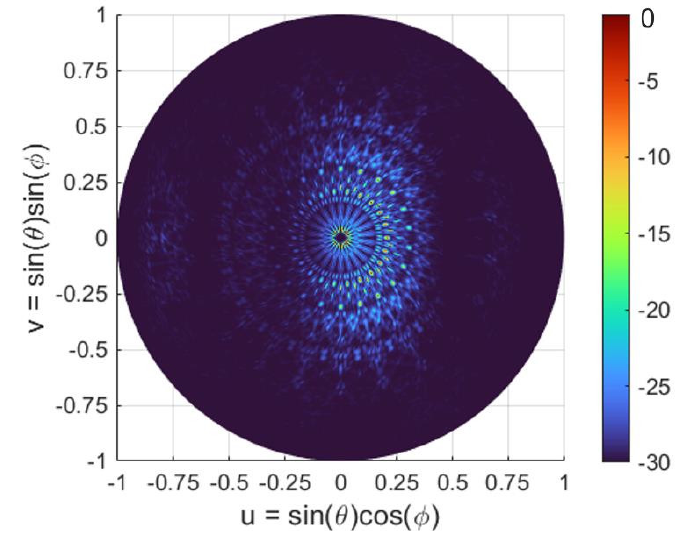
Figure 6. An array far-field pattern representation in a uv space for the Array #1 , with the operating wavelength of 1.55 μm, and steering to θ A = 0° and Φ A = 0°. The peak beam is radiated at θ = θ 0 = 6° and Φ = Φ 0 = 0°.